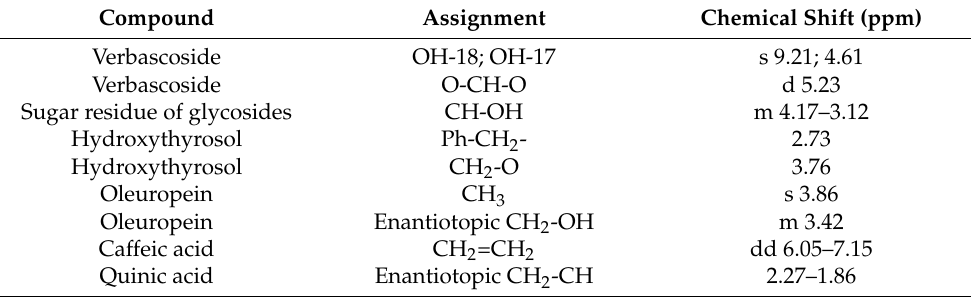
Table 2. Characterization of LOMW by 1 H-NMR spectroscopy.